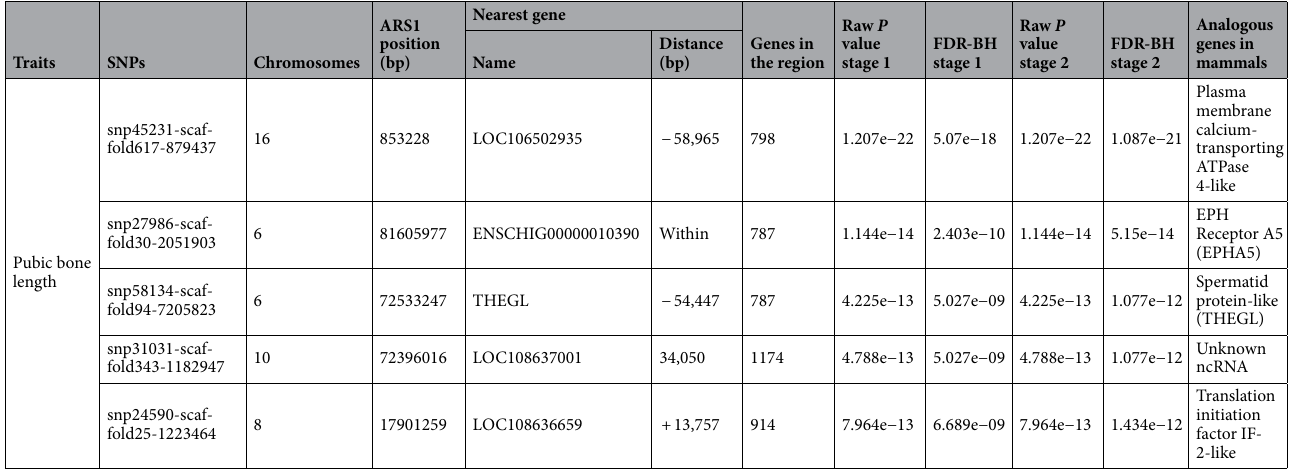
Table 2. Genome-wide significant SNPs with their candidate genes affecting body weight and morphometric traits among seven Punjab goat